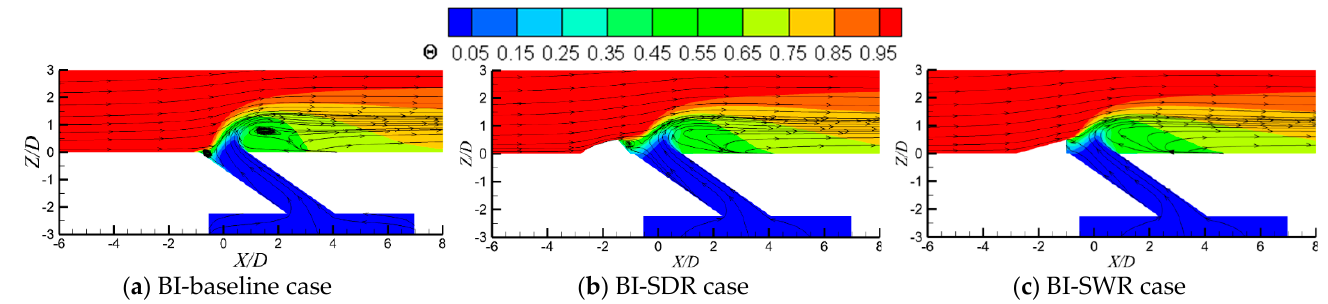
Figure 8. Dimensionless temperature contours and streamlines on film-hole centerline plane in BI cases.